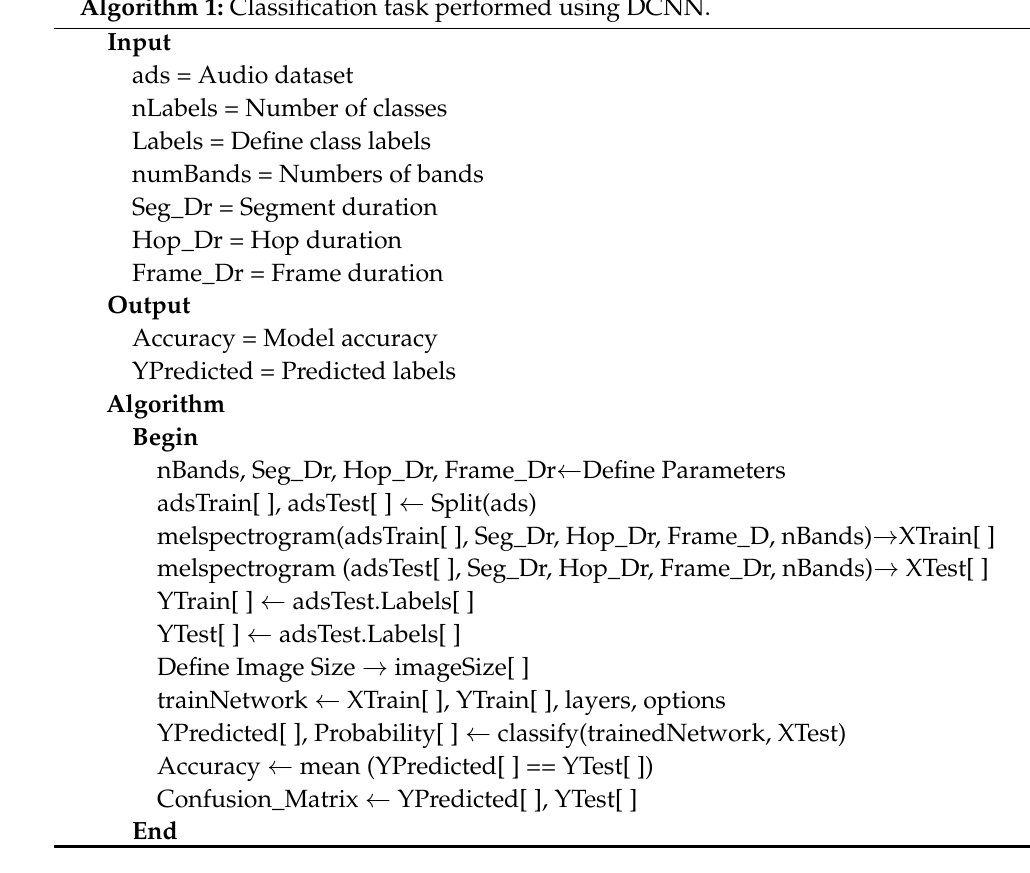
Figure 6. Deep convolution neural network architecture. Algorithm 1: Classification task performed using